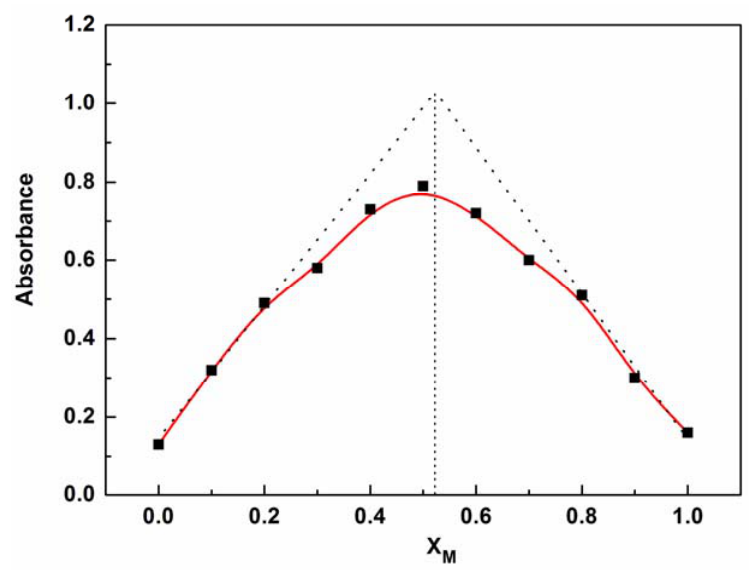
Figure 3. Job’s plot for the determination of the binding stoichiometry of P1 with Zn 2+ obtained from variations in absorption at 436